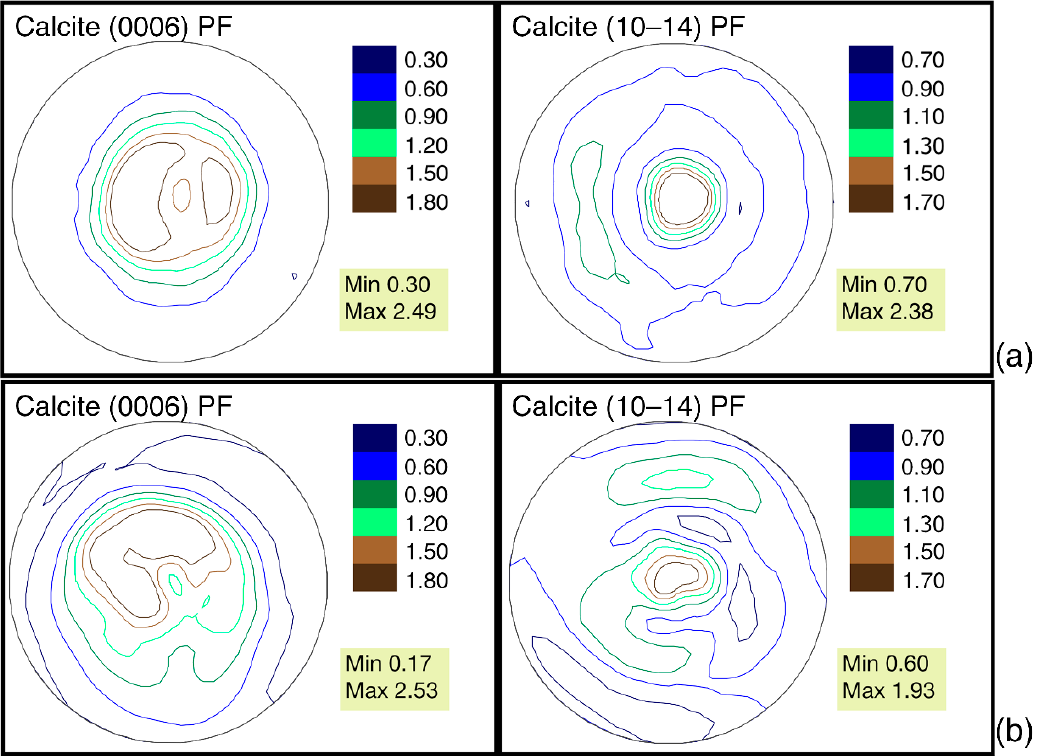
Figure 9. Calcite pole figures of the thick-walled valves of Ostrea edulis Linnaeus, 1758: ( a ) right valve, coast near the village of Maly Utrish, Black Sea; ( b ) left valve, Portugal, coast near the port of Lagos.